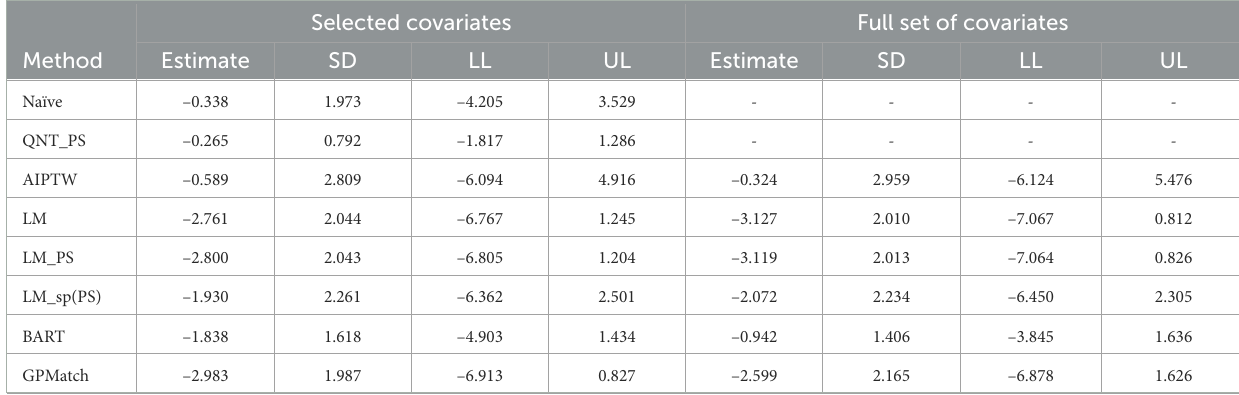
TABLE 4 Results of case study ATE estimates with none-matching methods.